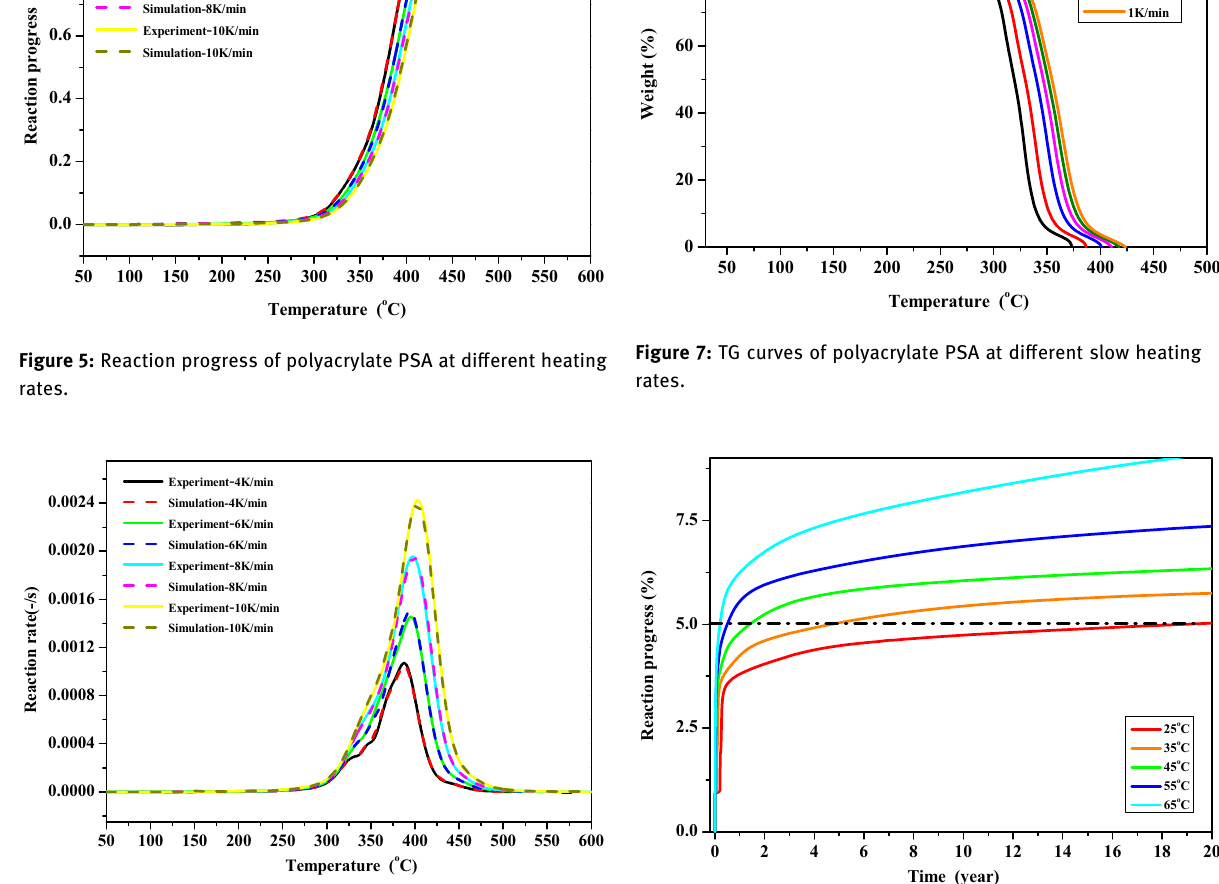
Figure 8: Life curves of polyacrylate PSA at di ff erent